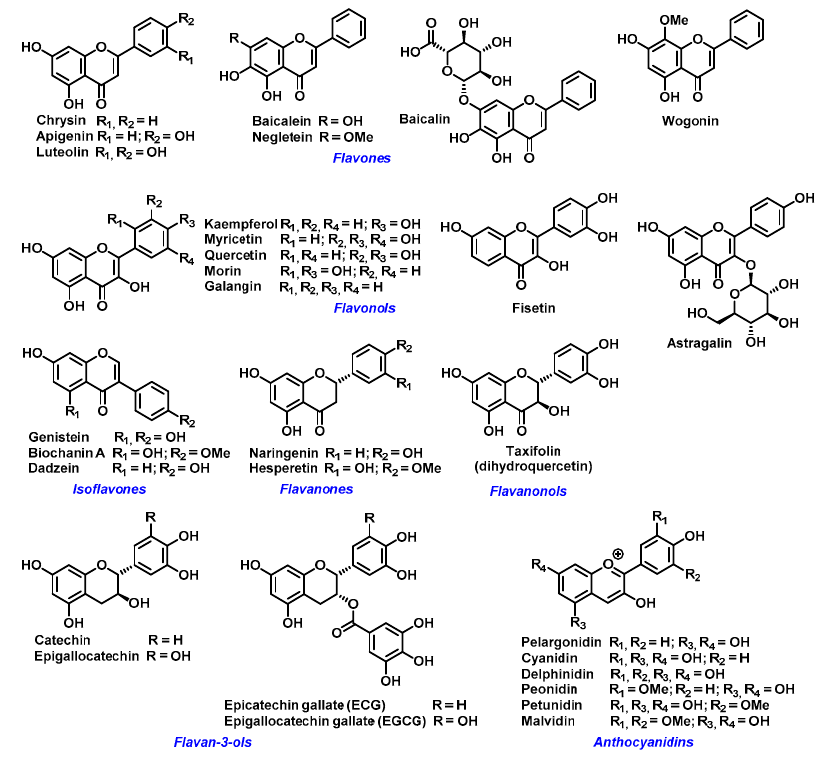
Figure 3. Examples of biologically active